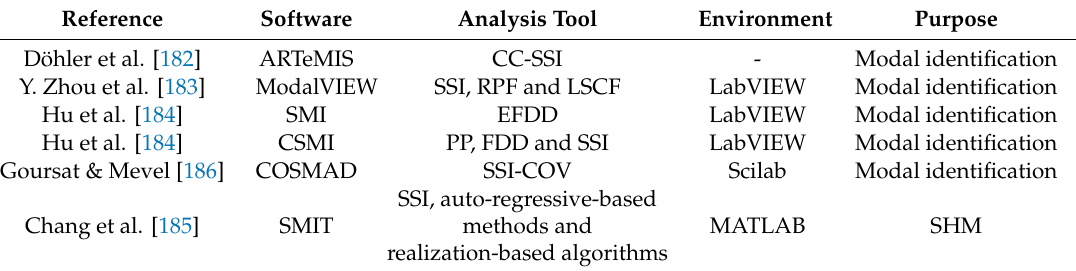
Table 10. SSI-based commercially available software for SHM and modal